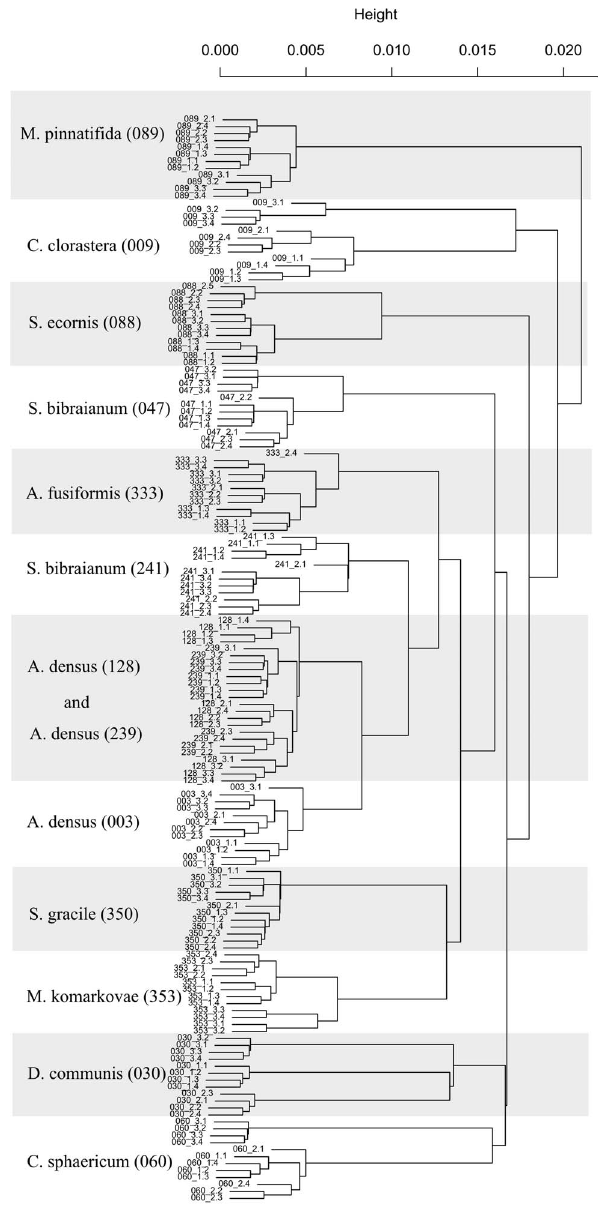
Fig. 5. Dendrogram generated by hierarchical cluster analysis (HCA) of the strains, based on data from windows III and V of the 9-point first derivative spectra (1500–1200 cm 2 1 and 900–675 cm 2 1 ). 1000 replicate bootstrap values are shown, except for nodes discriminating film replicates. Strains of microalgae: Ankistrodesmus densus (003), Chlamydomonas clorastera (009), Desmodesmus communis (030), Selenastrum bibraianum (047), Coelastrum cf sphaericum (060), Scenedesmus ecornis (088), Micrasterias pinnatifida (089), Ankistrodesmus densus (128), Ankistrodesmus densus (239), Selenastrum bibraianum (241), Ankistrodesmus fusiformis (333), Selenastrum gracile (350) and Monoraphidium komarkovae (353).